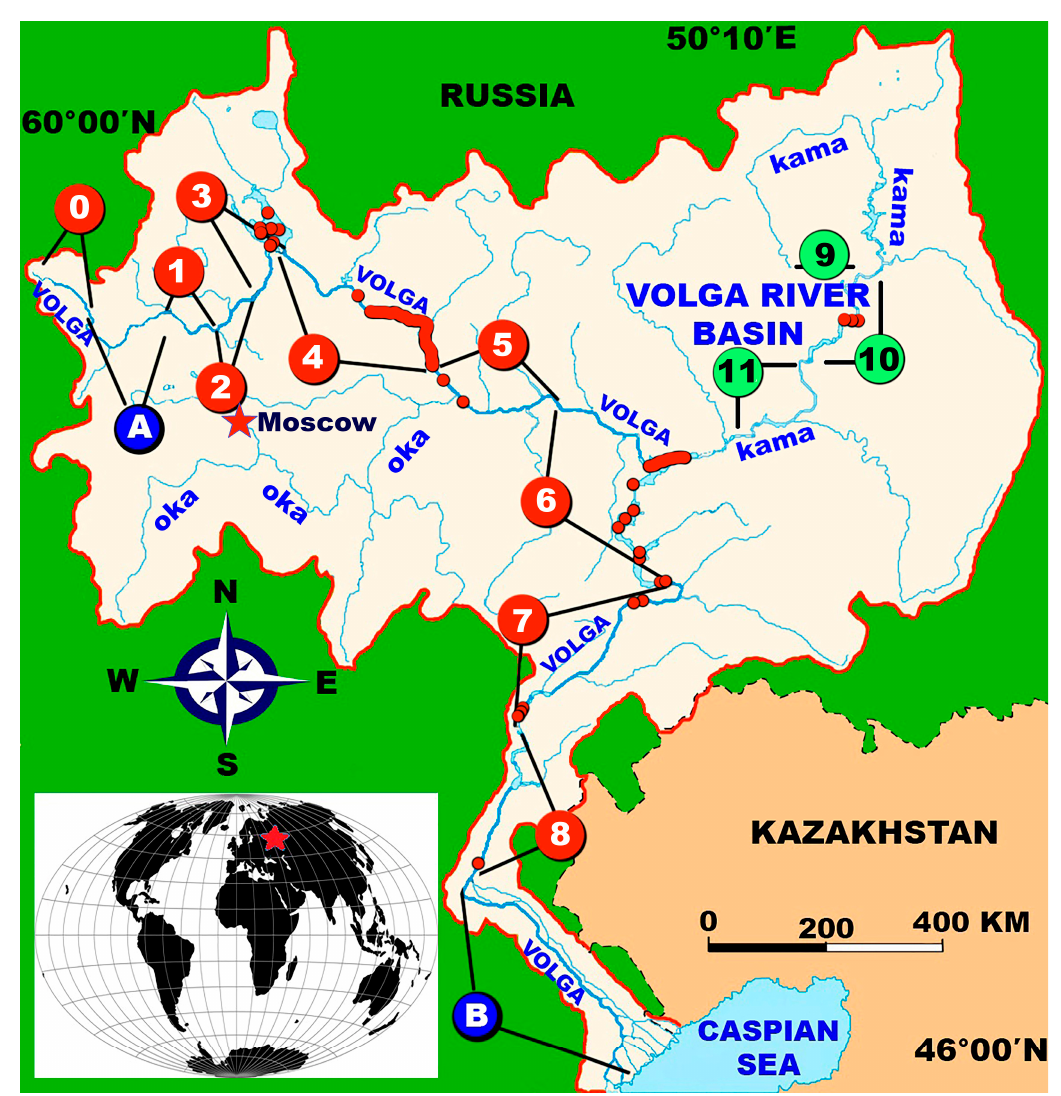
Figure 1. Distribution of the Pallas’s Gull ( Ichthyaetus ichthyaetus ) in summer and autumn 2020–2022 in the fairway of the Volga–Kama reservoirs, the location of reservoirs and unregulated sections of the Volga. The red star in the inset shows the location of the Volga basin. Red circles with numbers indicate the Volga reservoirs: 0—Upper Volga; 1—Ivankovo; 2—Uglich; 3—Rybinsk; 4—Gorky; 5—Cheboksary; 6—Kuibyshev; 7—Saratov; 8—Volgograd. Green circles indicate the Kama reservoirs: 9—Kama; 10—Votkinsk; 11—Nizhnekamsk. Blue circles indicate unregulated sections of the Upper (A) and Lower (B) Volga. The small black-and-red circles and red thick lines are the sites of sightings of the Pallas’s Gull in the reservoirs.